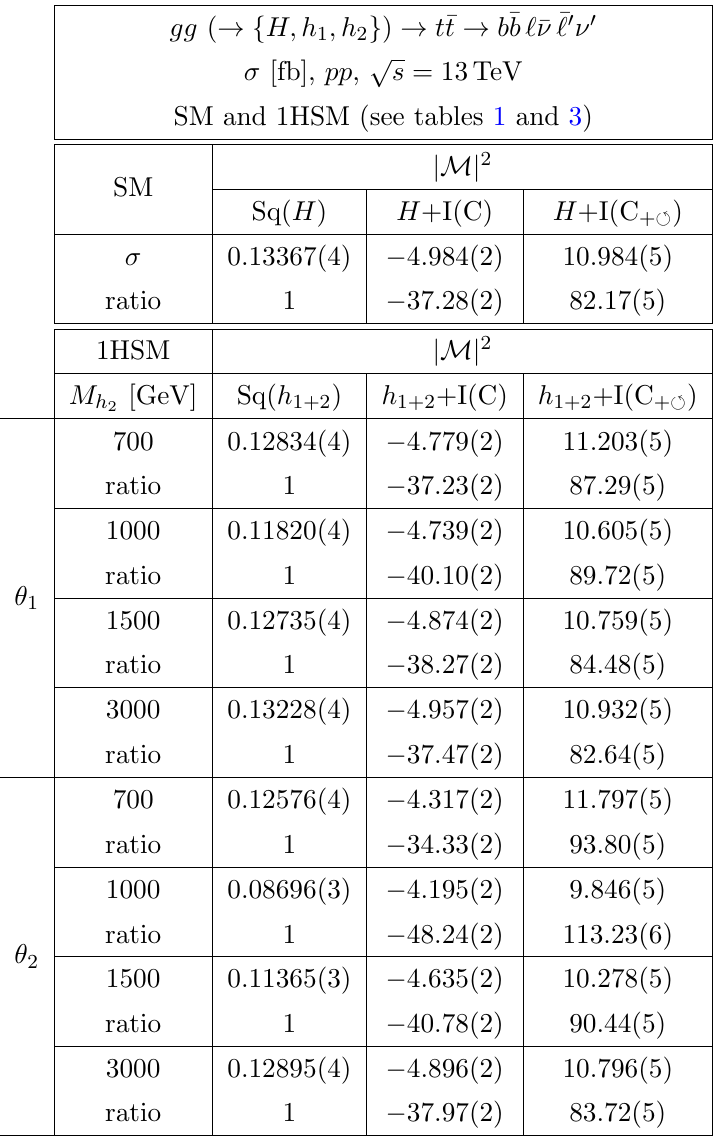
H; h ; h t (cid:22) t b (cid:22) b ‘ (cid:22) (cid:23) (cid:22) ‘ 0 (cid:23) 0 in pp collisions at p s = 13 TeV 1 2 g ) ! ! f !